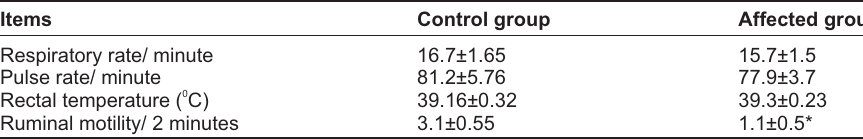
Table-1: Vital parameter differences between healthy control and foreign body impacted goats.